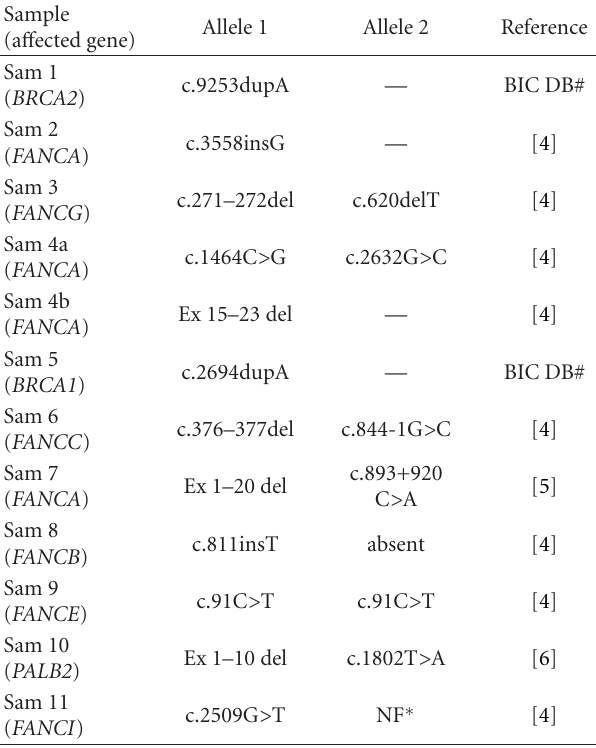
Table 1: Selected FA samples with mutations previously identified by Sanger sequencing and multiplex ligation-dependent probe amplification (MLPA), used for validation of the next-generation sequencing